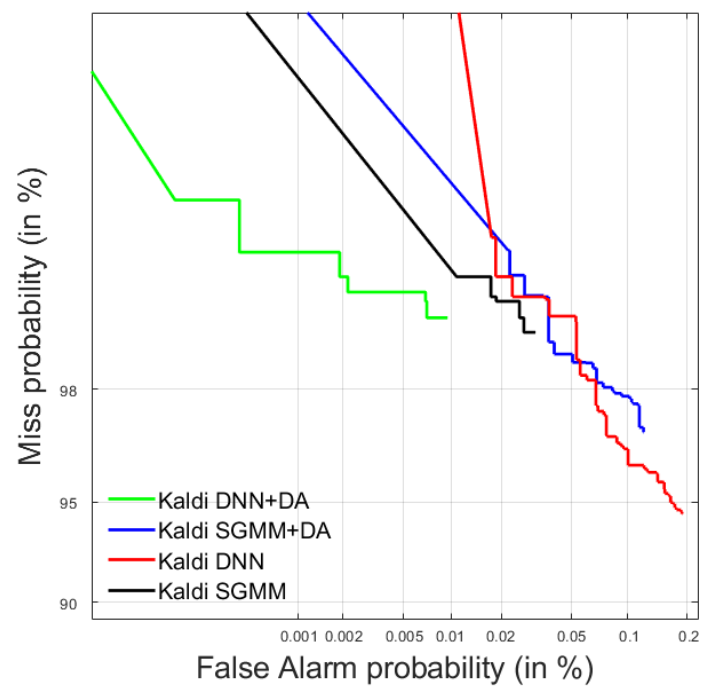
Figure 3. DET curves of the STD systems for MAVIR development